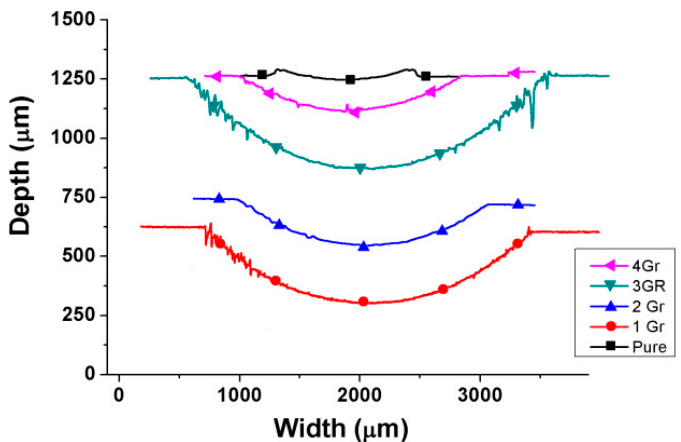
Figure Figure 5. Cross-sections of the worn tracks for pure copper and the composite specimens. For comparative purposes, the curves of the different specimens are offset on the y -axis.